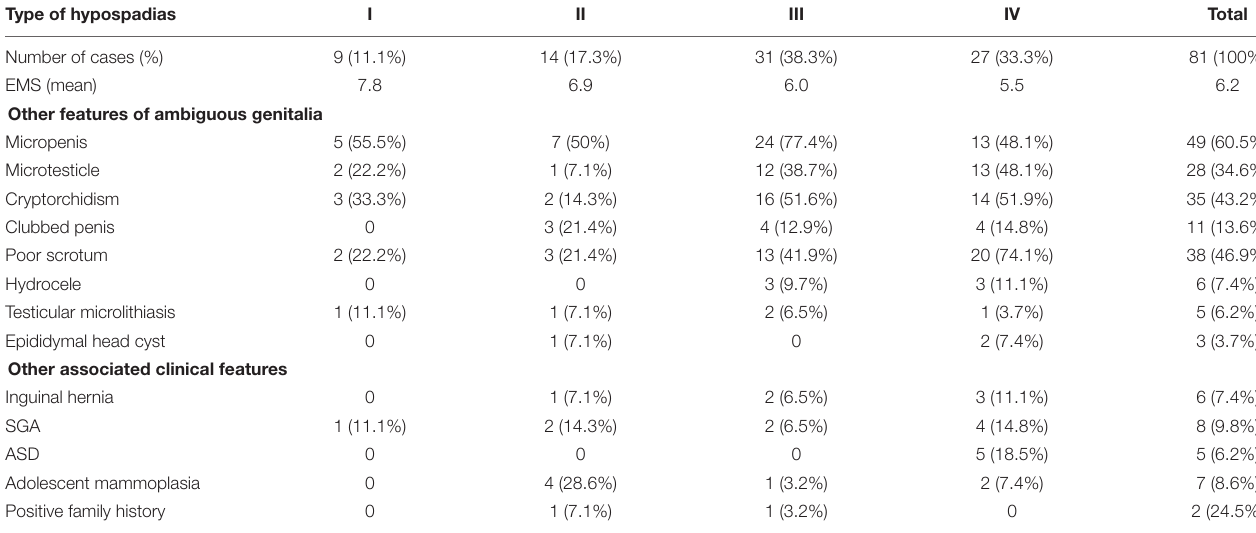
TABLE 1 | Clinical characteristics of 81 patients diagnosed with